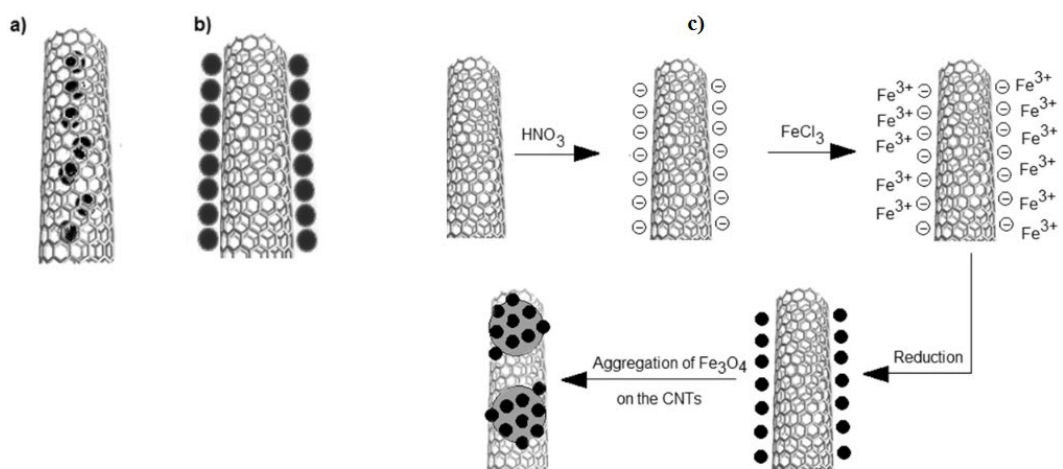
Fig. 5. Different strategies for the preparation of the M-CNT composite by the combination of the M-NP and CNTs. a) Endohedral functionalization; b) Exohedral functionalization; c) Preparation of M-CNT composites by exohedral functionalization. Schematic description of the self-assembly of magnetite beads along MWCNTs in the hydrothermal synthesis [39].